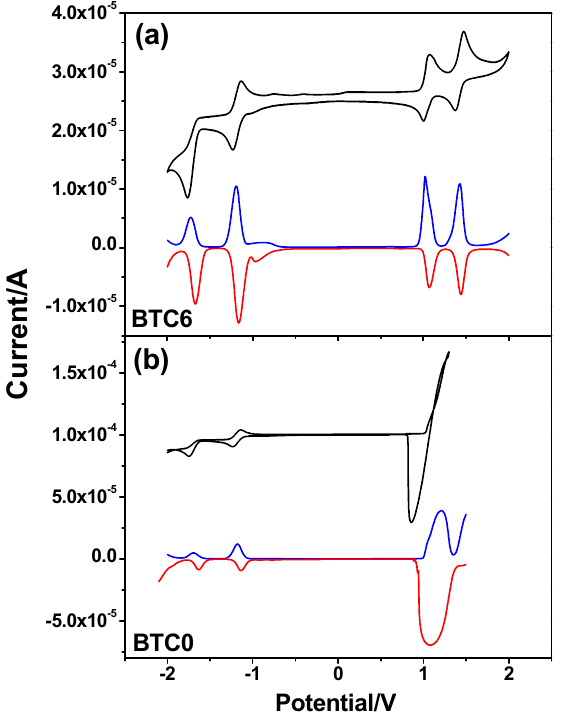
Figure 4. Cyclic voltammetry (CV) of BTC6 ( a ) and BTC0 ( b ) in a dichloromethane solution containing the electrolyte 0.1 M NBu 4 PF 6 . The compounds were measured at a concentration of 10 -3 M in the electrolyte solution, with an Ag wire reference electrode and a Pt disk working electrode (scan rate = 100 mV s − 1 ). Ferrocene was used as an internal standard. Differential pulse voltammetry (DPV) was measured using the same electrolyte with 50 ms pulse width, 50 mV amplitude, 200 ms pulse period, and 4 mV potential increment.